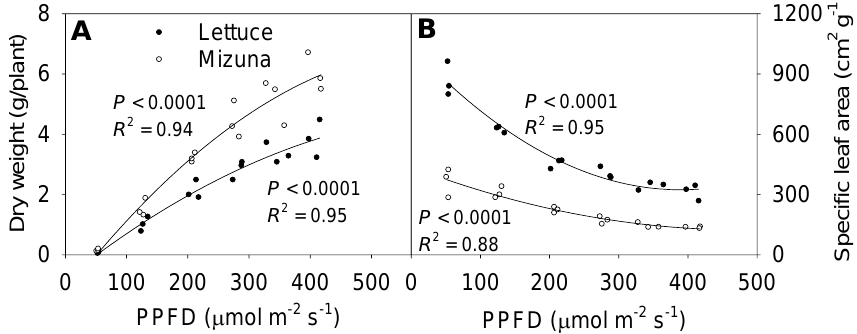
Figure 7. ( A ) Shoot dry weight and ( B ) specific leaf area of mizuna ( Brassica rapa var. japonica ) and lettuce ( Lactuca sativa ‘Green Salad Bowl’) plants grown at six different photosynthetic photon flux densities (PPFD s ) for 27 and 28 days, respectively. Specific leaf area is the ratio between leaf area and dry weight. Each data point represents the mean of nine plants.